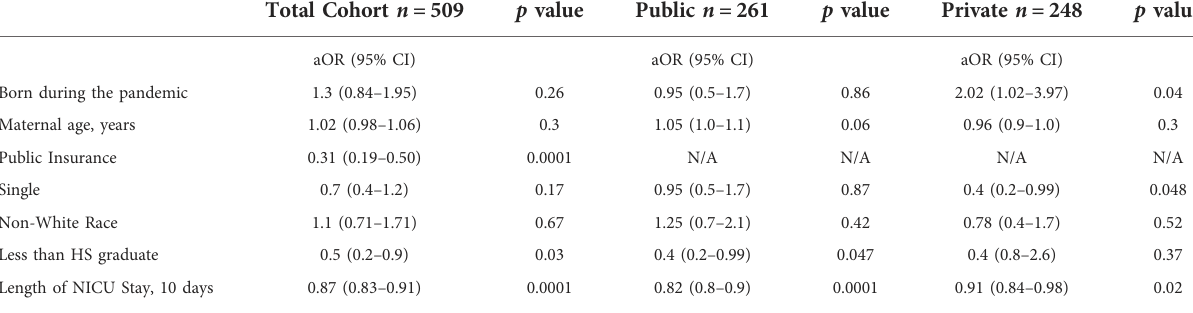
TABLE 3 Logistic regressions of maternal & infant characteristics to predict MOM at discharge for the entire study